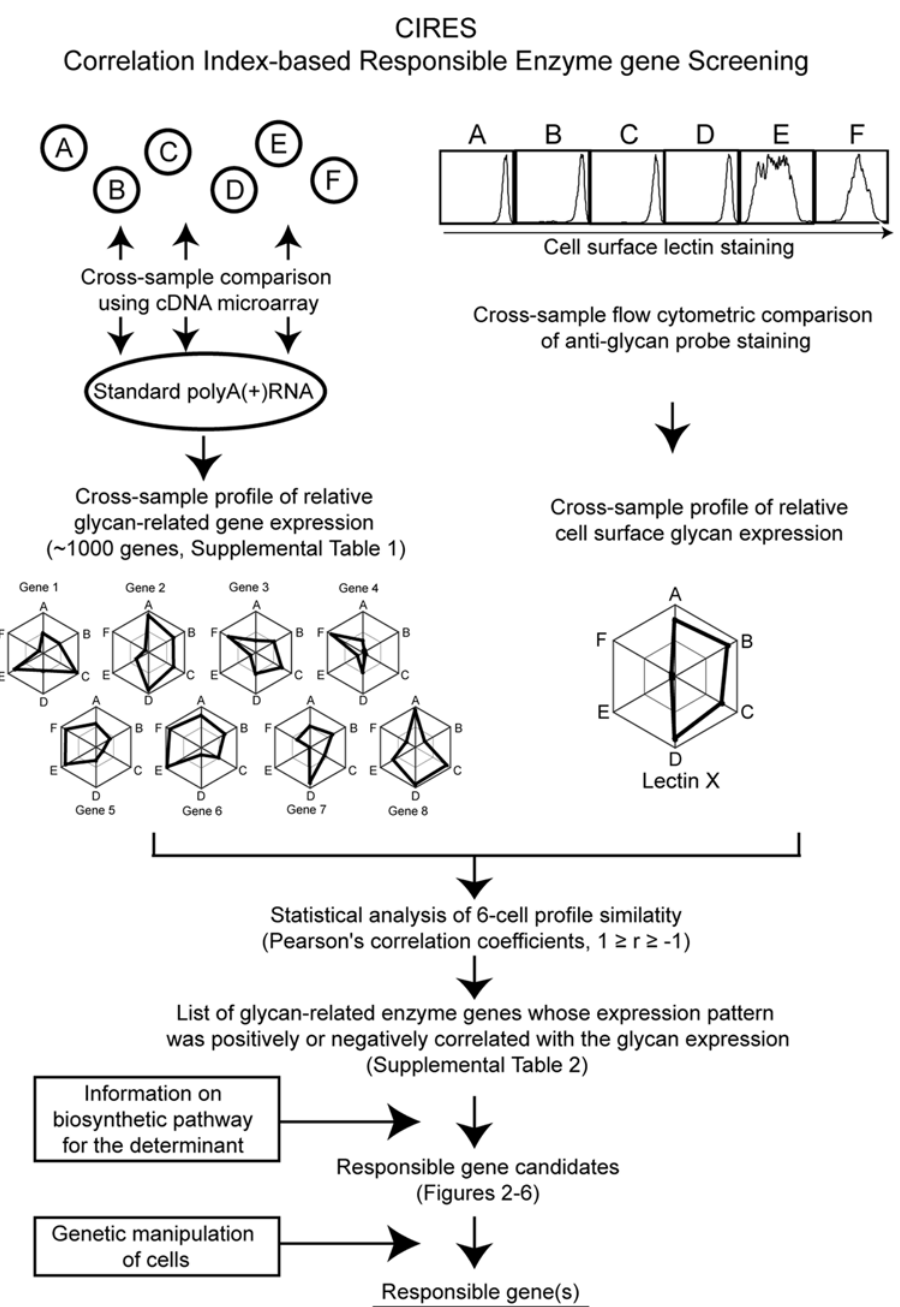
Figure 1. Schematic of the CIRES concept. The expression patterns of about 1000 glycan-related genes were profiled in a set of six different cell lines (A–F) by comparing the microarray binding of cellular cDNA and reference polyA( + ) RNA and calculating the relative expression values (Table S1). The polygons in the left web graphs represent the relative gene expression profiles of eight glycan-related genes selected as examples. In these graphs, the difference in relative gene expression is expressed on a log scale, where the edge of the polygon corresponds to the strongest expression in each cell line (A–F). The same set of six cell lines were examined for cell-surface glycan expression using fluorescently labeled plant lectins and flow cytometry; the strength of the glycan expression is plotted as relative values among the six lines, where the edge of the polygon represents the strongest expression (web graph on top right). The glycan expression profiles were analyzed for correlations with the glycan-related gene expression profiles. Similarities and dissimilarities between the profiles were assessed using Pearson’s correlation coefficient, which has values ranging from -1 (no correlation) to 1 (perfect correlation). A complete list of the genes found to be positively or negatively correlated with plant lectin staining patterns is presented in Table S2. Genes known to affect the biosynthesis of an epitope were selected from among the correlated genes (shown for each lectin in the tables on the right in Figures 2–6). A correlated gene identified by CIRES was confirmed as the gene responsible for regulating the biosynthesis of a particular glycan by transferring the gene into another cell line of the set, via gene transfer techniques such as retrovirus-mediated overexpression, and looking for a related change in epitope expression.